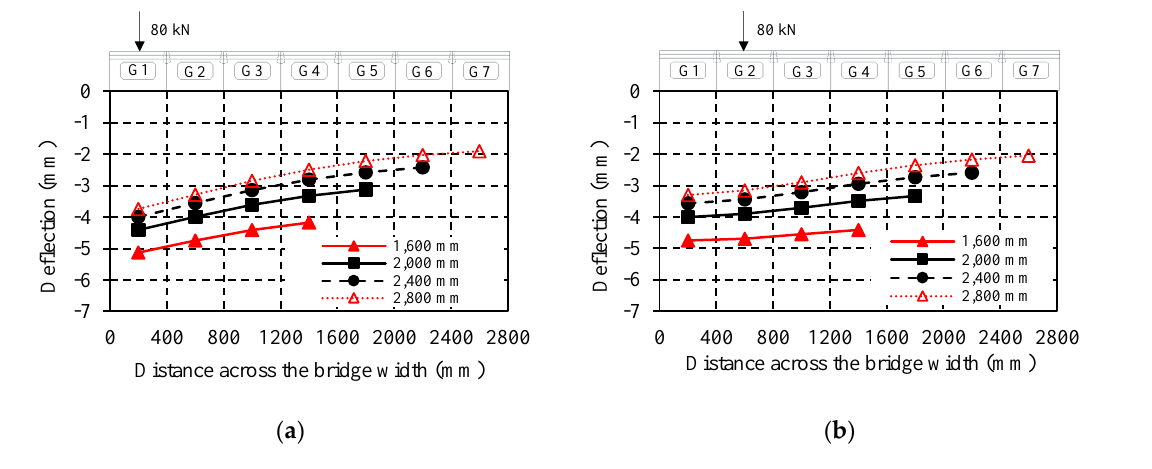
Figure 16. Mid-span deflection profile for different bridge widths: ( a ) exterior girder G1 loaded and ( b ) interior girder G2 loaded.